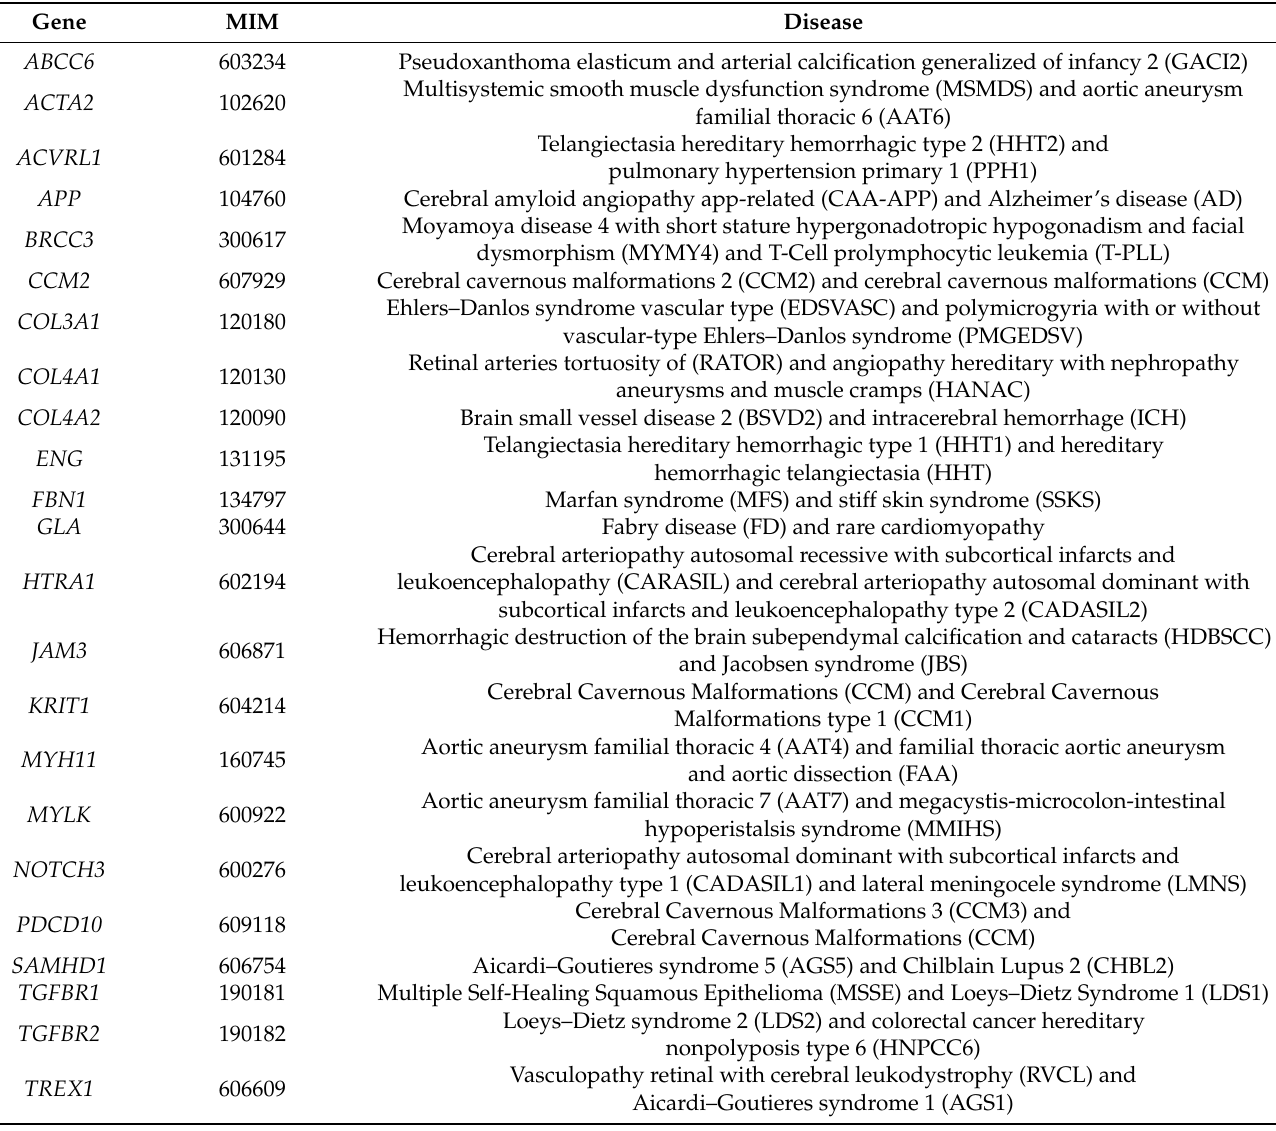
Table 1. Cerebro panel: 23 genes associated with cerebrovascular diseases of genetic